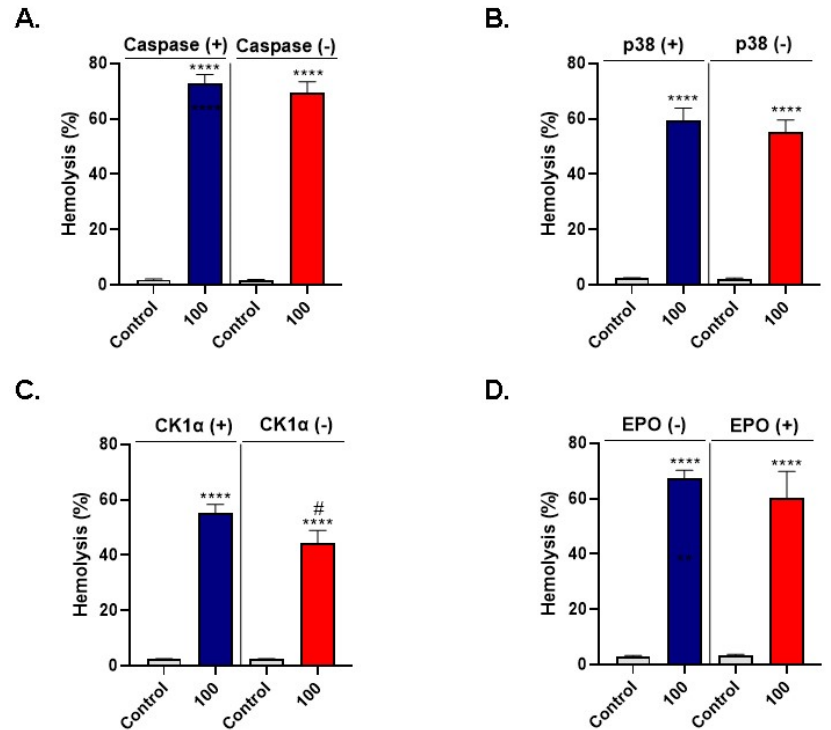
Figure 8. LA-induced hemolysis is mitigated by D4476. Hemolytic rates under inhibition of ( A ) caspase by zVAD, ( B ) p38 MAPK by SB203580, and ( C ) CK1 α by D4476. ( D ) LA-induced hemolysis under EPO supplementation. **** ( p < 0.0001) indicates significantly different values from control conditions whereas # ( p < 0.05) indicates statistical significance compared to LA-treated cells.